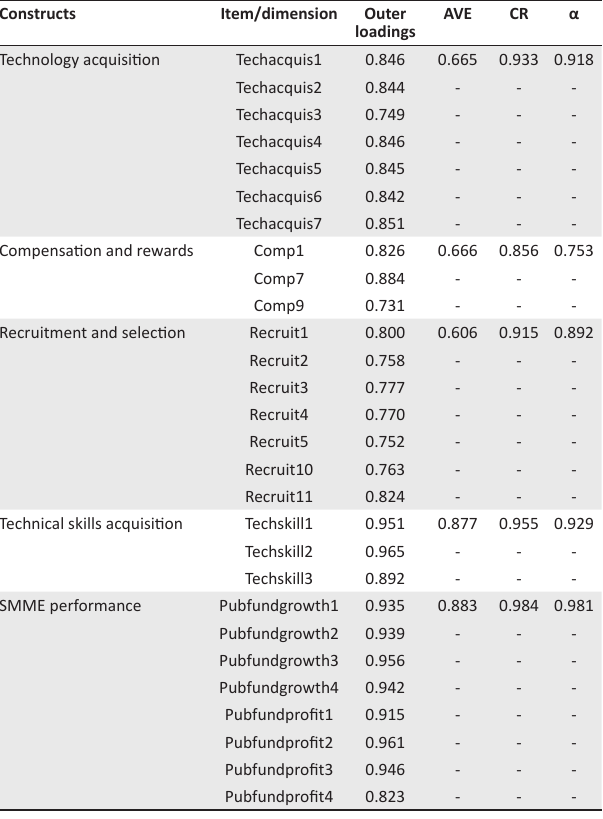
TABLE 1: Results of model’s convergent